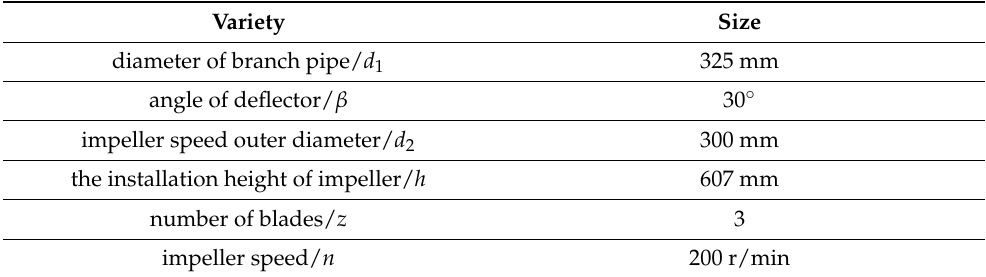
Table 2. Model parameters and original data.